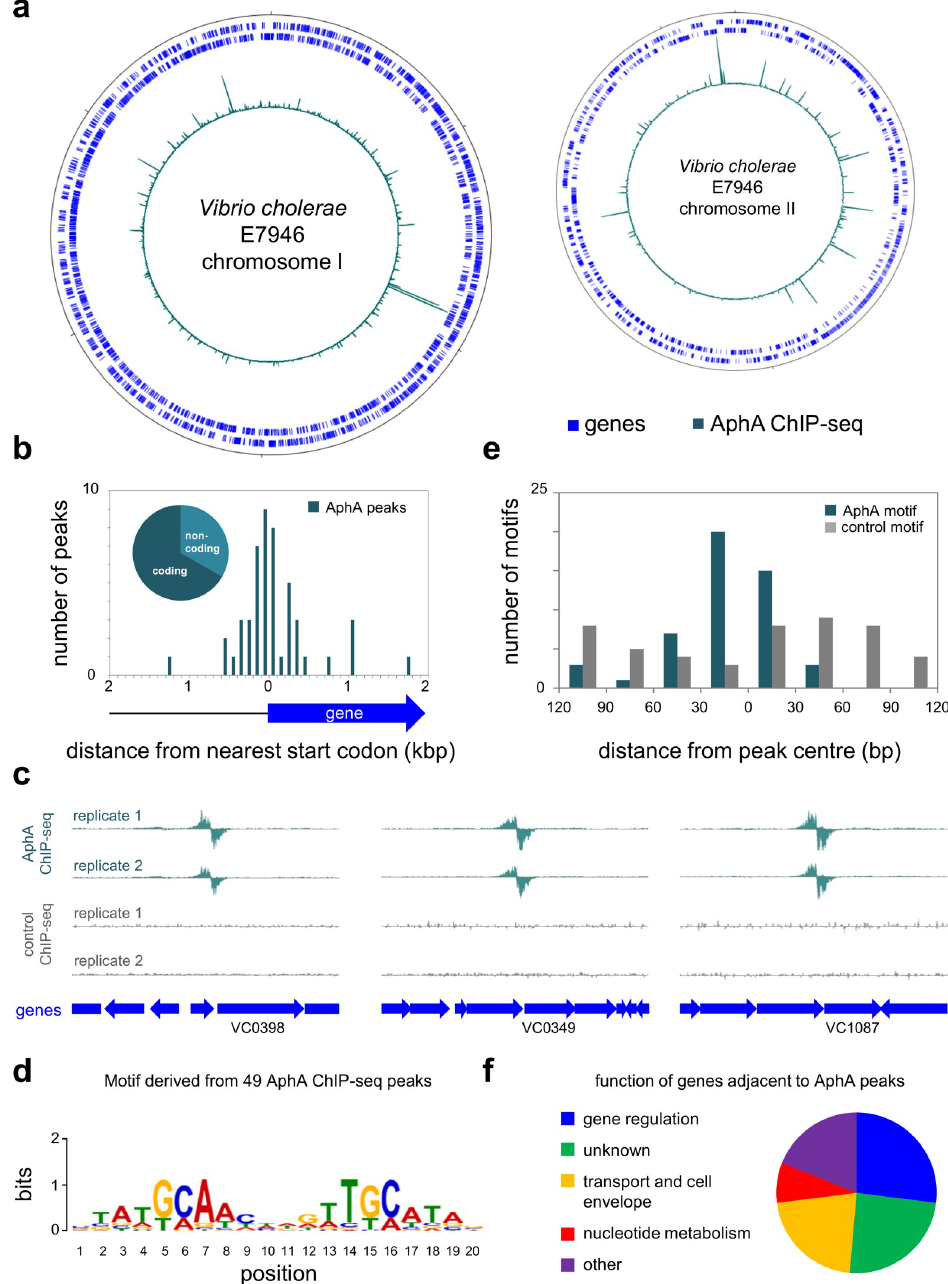
Fig 1. Genome-wide binding of AphA in Vibrio cholerae . (a) Binding of AphA across both Vibrio cholerae chromosomes. In each plot the outer two tracks (blue) are genes orientated in the forward or reverse direction. The AphA ChIP-seq binding signal (teal) is the inner profile. Position 1 of each chromosome is denoted by the tick mark at the top of each plot. Further tick marks are 1 Mbp apart. (b) Position of AphA binding peaks with respect to genes. The histogram shows the distribution of AphA binding peak centres with respect to the start codon of the nearest gene. The pie chart shows the proportion of binding peaks in coding or non-coding DNA. (c) Example AphA ChIP-seq binding peaks. The panel illustrates intragenic AphA binding peaks close to gene (block arrow) start codons. ChIP-seq coverage plots are shown for individual experimental replicates. Data for AphA are in teal and control profiles are grey. Signals above or below the horizontal line correspond to reads mapping to the top or bottom strand respectively. (d) Sequence motif derived from AphA binding peaks using MEME. (e) Distances between AphA binding peak centres and motifs. Data are shown as a histogram. The AphA motif is that shown in panel d. The control motif (5’- NAANTGCANTTN-3’) was identified by MEME as lacking statistical significance (E = 1.1e+25). (f) Pie chart showing gene classes targeted by